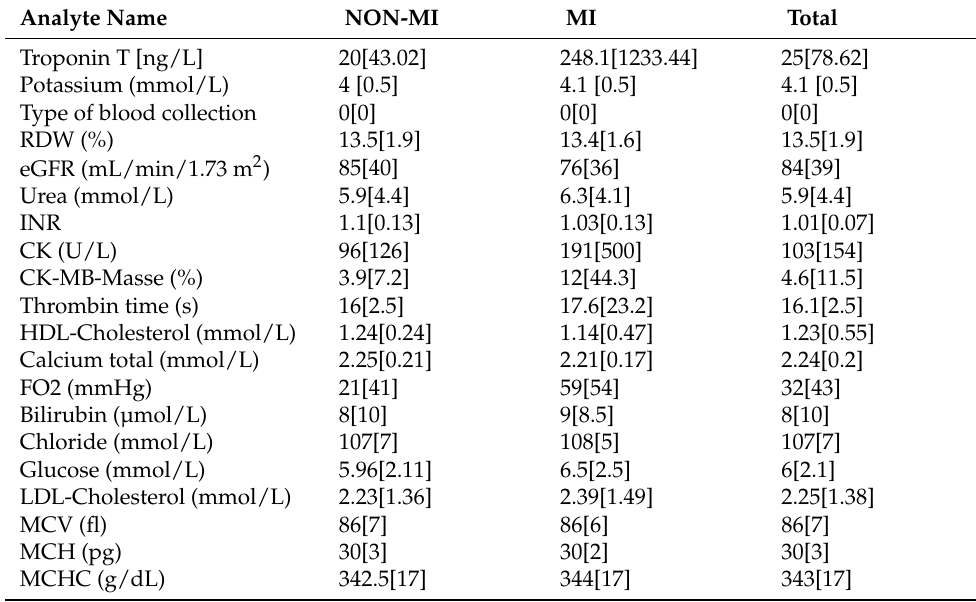
Table 3. Median and IQR of the analytes with an inclusion probability of 95% and above. Based on Table 2, the values for each analyte are included with an inclusion probability of 95% and above in at least one of the figures listed with the median value and IQR. Columns 2–4 are divided into patients without myocardial ischemia (non-MI), with myocardial ischemia (MI), and the total number (total). In Table 3, the unit of measurement is noted in the first column with the analyte, and the median value and the IQR (placed in the square bracket) are displayed in columns 2–4. As “Type of blood collection” does not come with a value, calculations here were impossible; therefore, its value was placed at zero. Note that FO2 contains data from both, arterial and venous